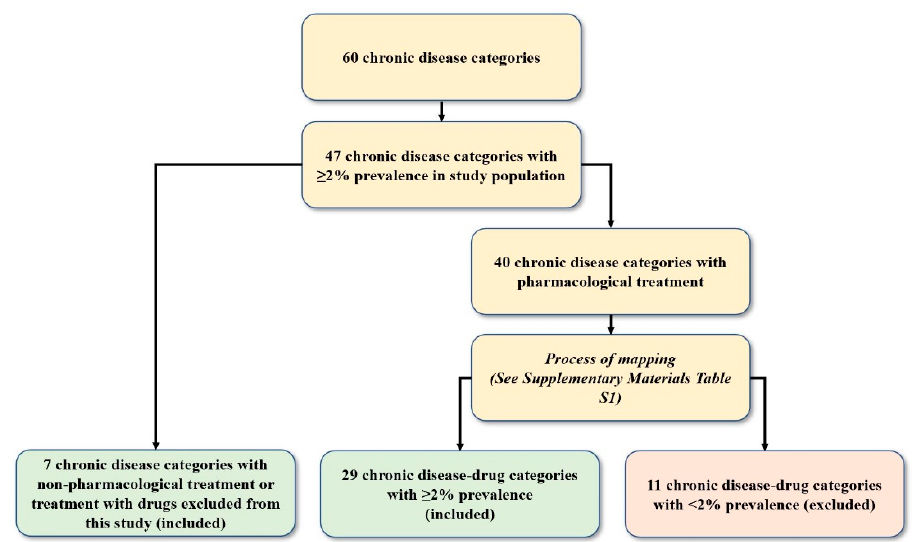
Figure 2. Number of significant chronic disease or chronic disease-drug categories after mapping.